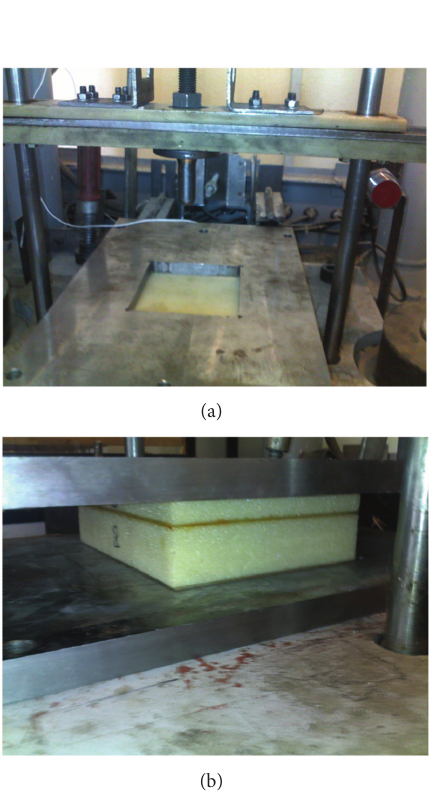
Figure 2: Description of the impact on a multilayer sandwich structure by the drop hammer testing machine.